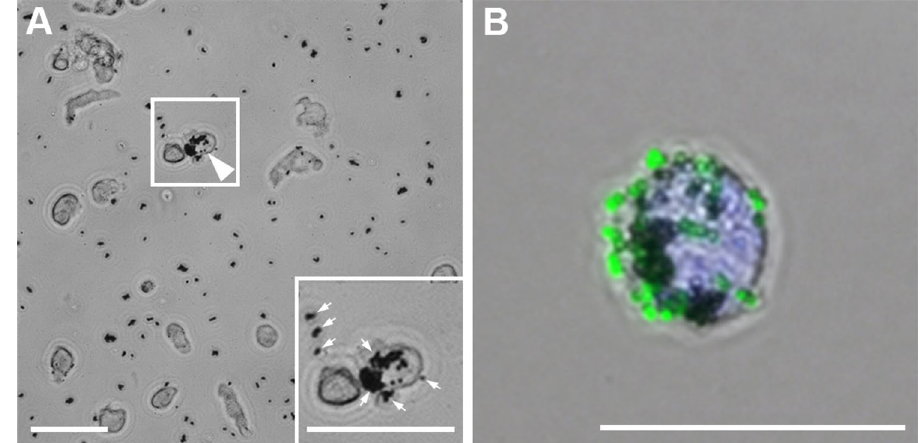
Figure 1. Dynabeads conjugated with anti-CD31 show binding to endothelial cells (white arrowhead and inset), whereas other non-endothelial cells were free of Dynabeads ( A ). Unbound and cell-attached Dynabeads can be observed as black dots (inset, small arrows). For verification of the anti-CD31-Dynabead conjugation, the ECs with their bound anti-CD31 Dynabeads were incubated with Alexa488 conjugated secondary antibodies directed against mouse IgGs, detecting the primary anti-CD31 antibody conjugated to the Dynabeads ( B ). The entire amount of anti-CD31 antibody was conjugated to the Dynabeads, since no CD31 staining of the EC membrane was detected. Scale: 50